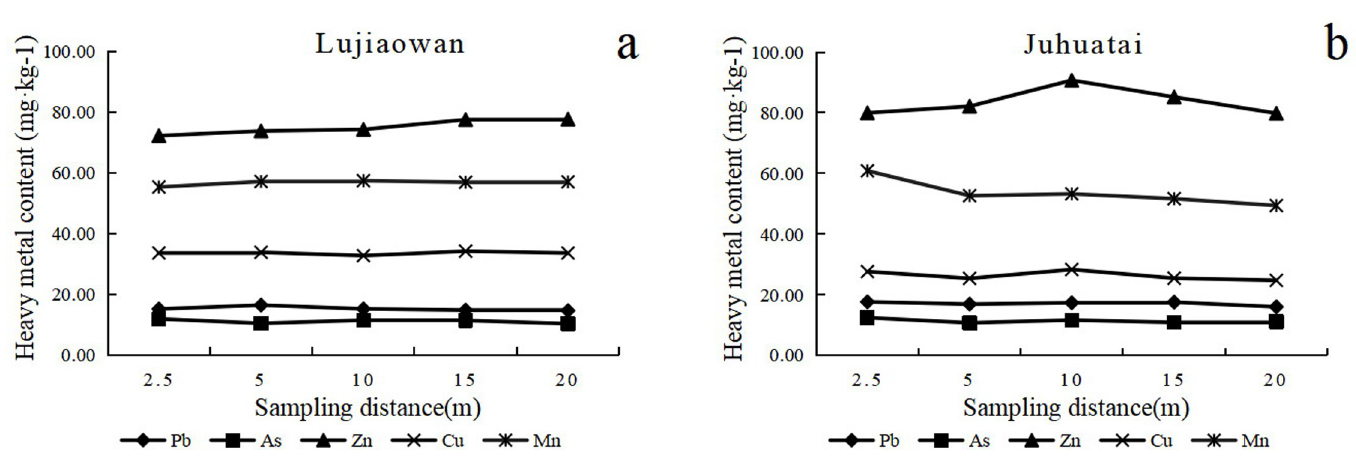
Fig 1. Concentrations of soil heavy metal at different sampling plots.